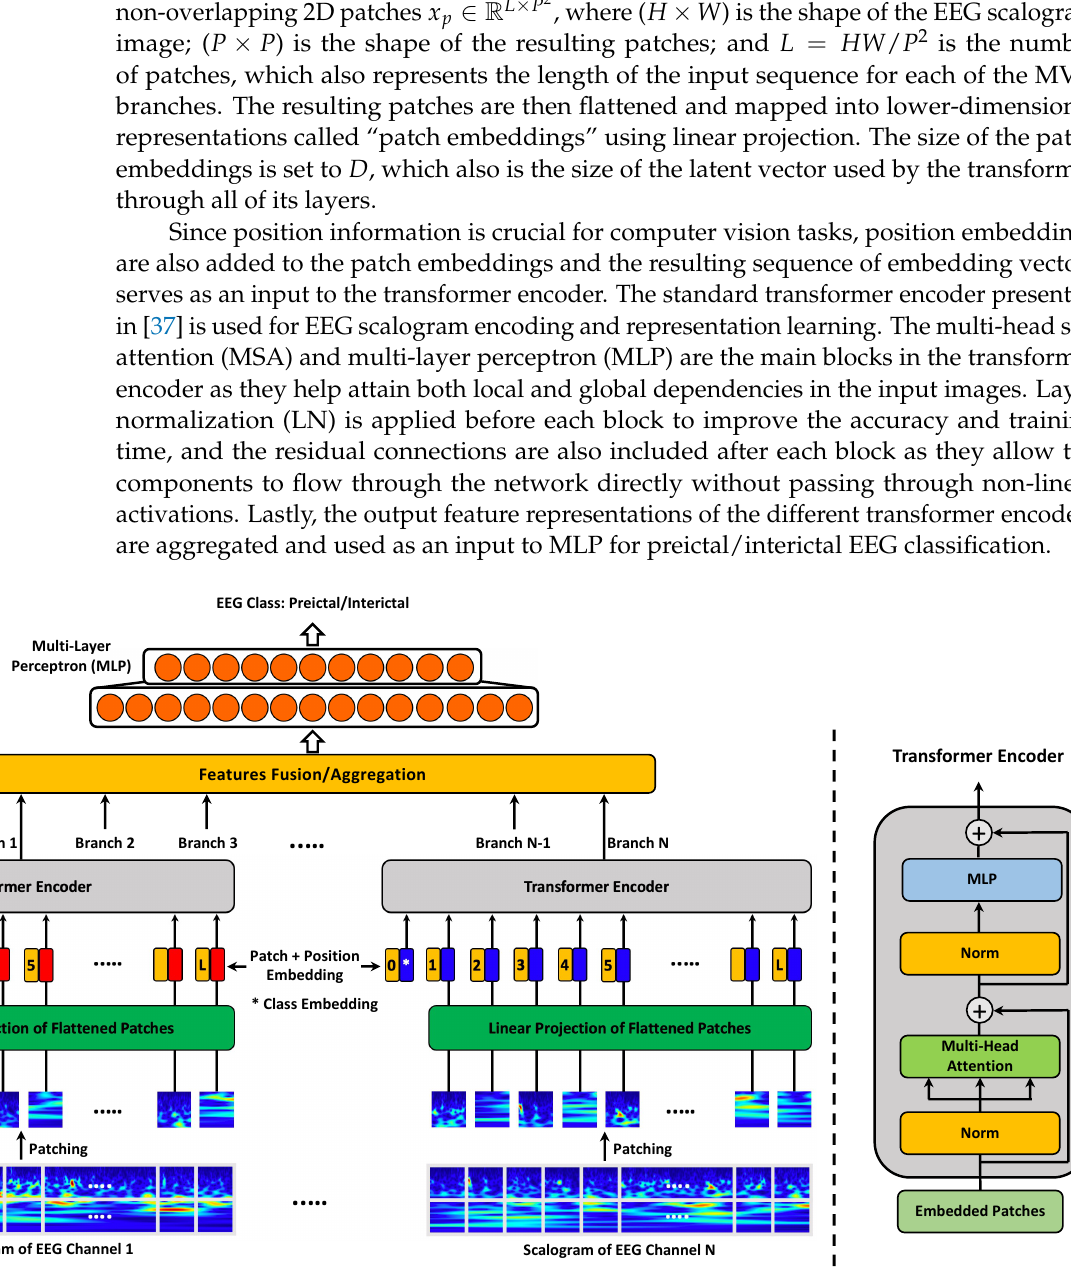
Figure 3. Framework of MViT for multi-channel EEG feature learning. It consists of a stack of N transformer encoders; each encoder processes image tokens from an individual EEG channel. The output feature representations are then concatenated and fed as an input to MLP for EEG